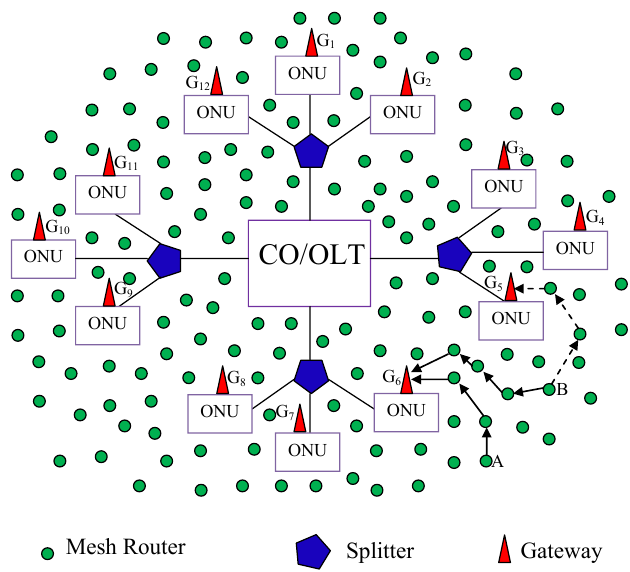
Figure 3. WOBAN with multiple